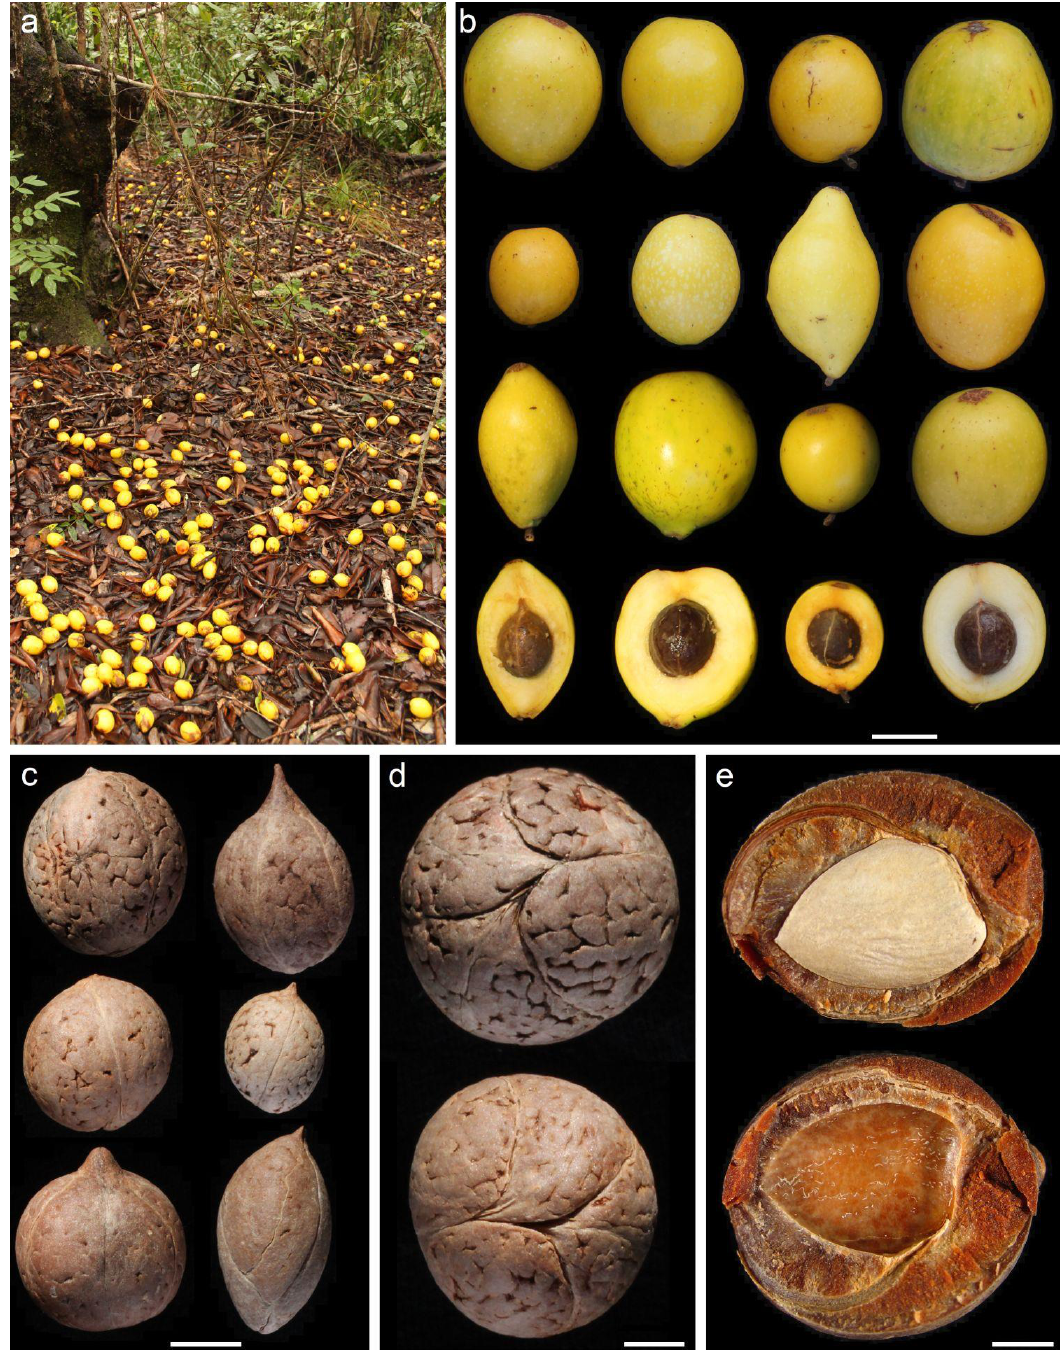
Figure 1. The fruit of Gomortega keule . ( a ) Fruits ripen and fall during the austral autumn and accumulated in large quantities on the ground due to the lack of consumption by extant native animals; ( b ) Morphological variation of G. keule fruits (bar scale = 3 cm); ( c ) Morphological variation of stones (bar scale = 1 cm); ( d ) Polar view of the stone showing the lines of carpel union (bar scale = 0.5 cm); ( e ) Open stone showing the hard thick lignified endocarp protecting the soft seed (bar scale = 0.5 cm).